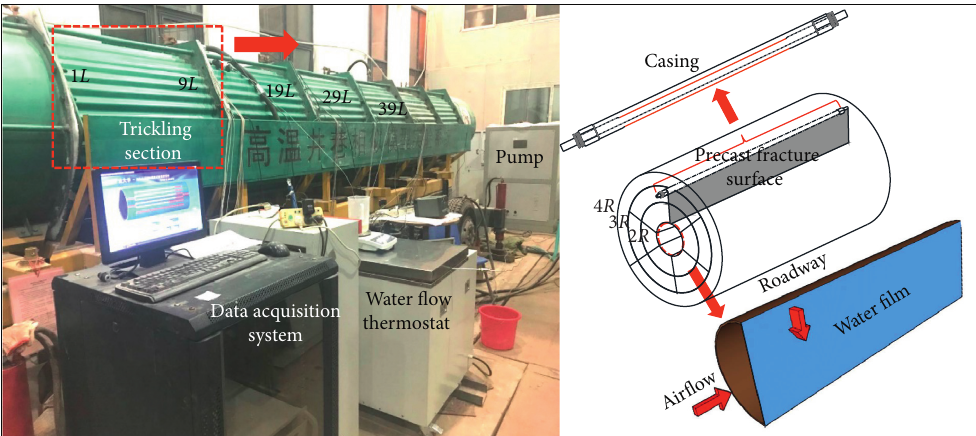
Figure 5: Preembedded seepage casing and precast fracture